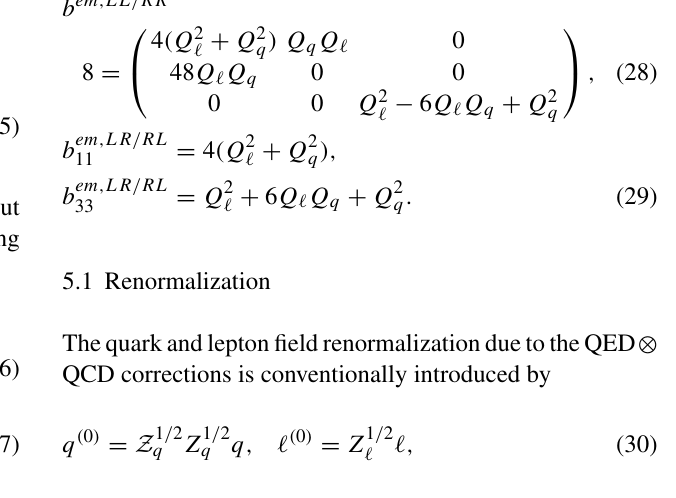
Table 4 Lower limits on the individual LFV scales (cid:7) for further